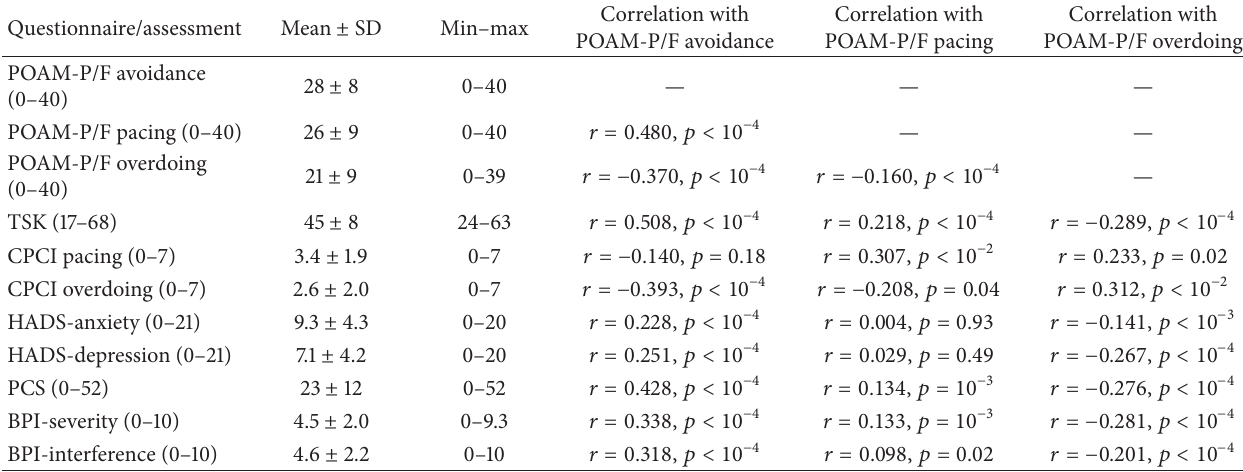
Table 1: Mean scores for questionnaires/assessments and correlations with POAM-P/F subscores.